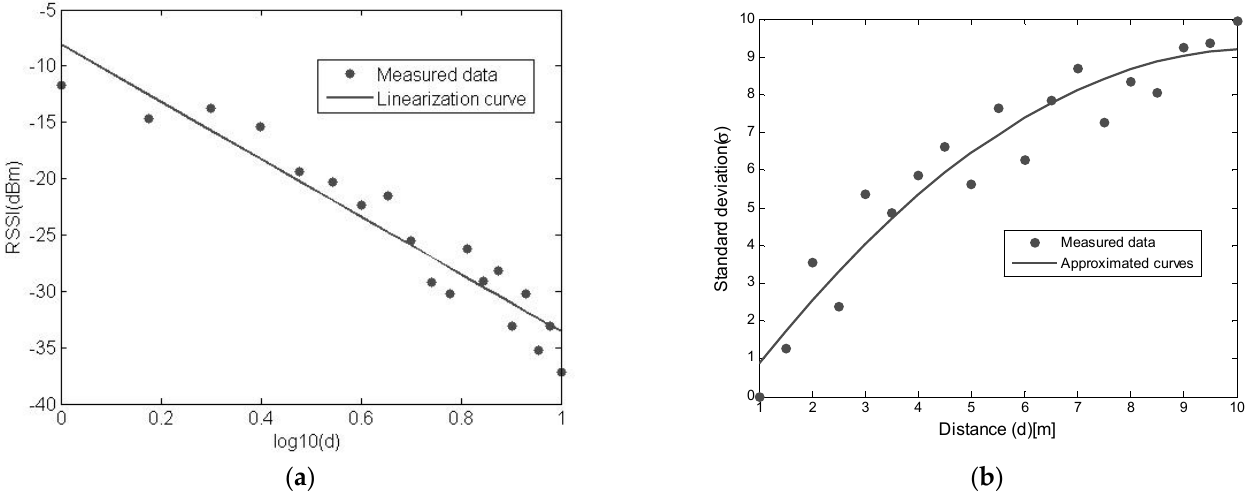
Figure 2. ( a ) Relationship of measured RSSI values and distance. ( b ) Relationship of the noise standard deviation and distance for measured data.